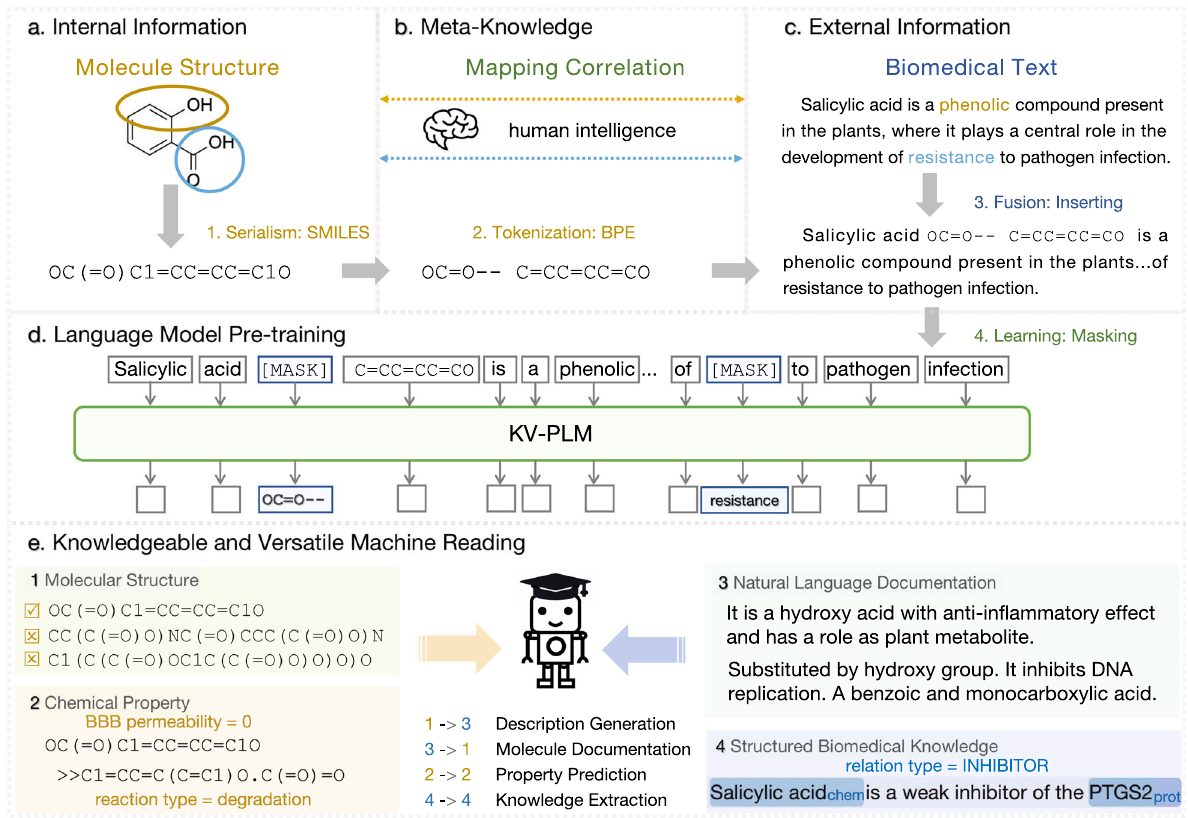
Fig. 1 Conceptual diagram of knowledgeable and versatile machine reading. Here we take salicylic acid as an example. Inspired by humans that versatilely learn meta-knowledge within and across different information, our machine reading system fi rst serializes, a molecule structures via BPE on SMILES strings, then inserts the substrings into c . large-scale corpus and learns b fi ne-grained mapping between different semantic units by d mask language modeling. In this way, the system can perform e knowledgeable and versatile reading, achieving good performance on both mono-information downstream tasks and versatile reading